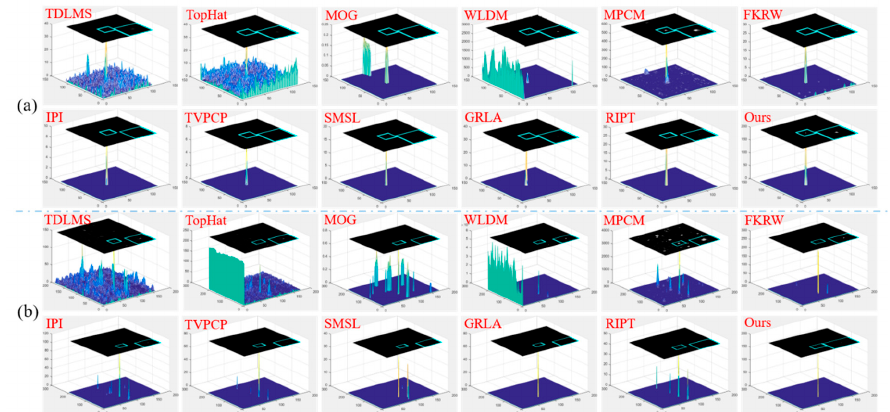
Figure 9. Detection results obtained by the proposed method over deep-space scenes compared with 11 comparative approaches. For better observation, the target images are integrated with their 3D stereogram. ( a ) Representative frame in Sequence 6. ( b ) Representative frame in Sequence 7. ( c ) Representative frame in Sequence 8. Remote Sens. 2020 , 12 , x FOR PEER REVIEW